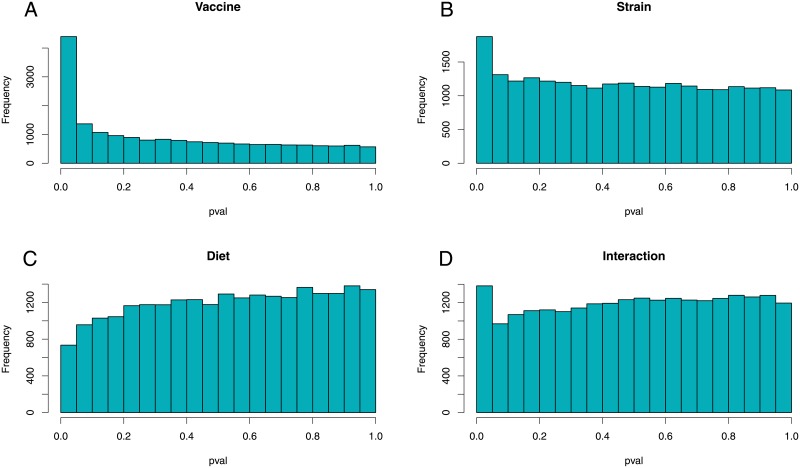
P-value distribution histogram.Ballgown stattest function used to specify effect of treatment and covariates. (A) Control fish (n = 6) versus vaccinated fish (n = 24). (B) Vaccinated fish only and strain as covariate (n = 24). (C) Vaccinated fish only and diet as covariate (n = 24). (D) Interaction analysis of diet and strain in vaccinated fish (n = 24).